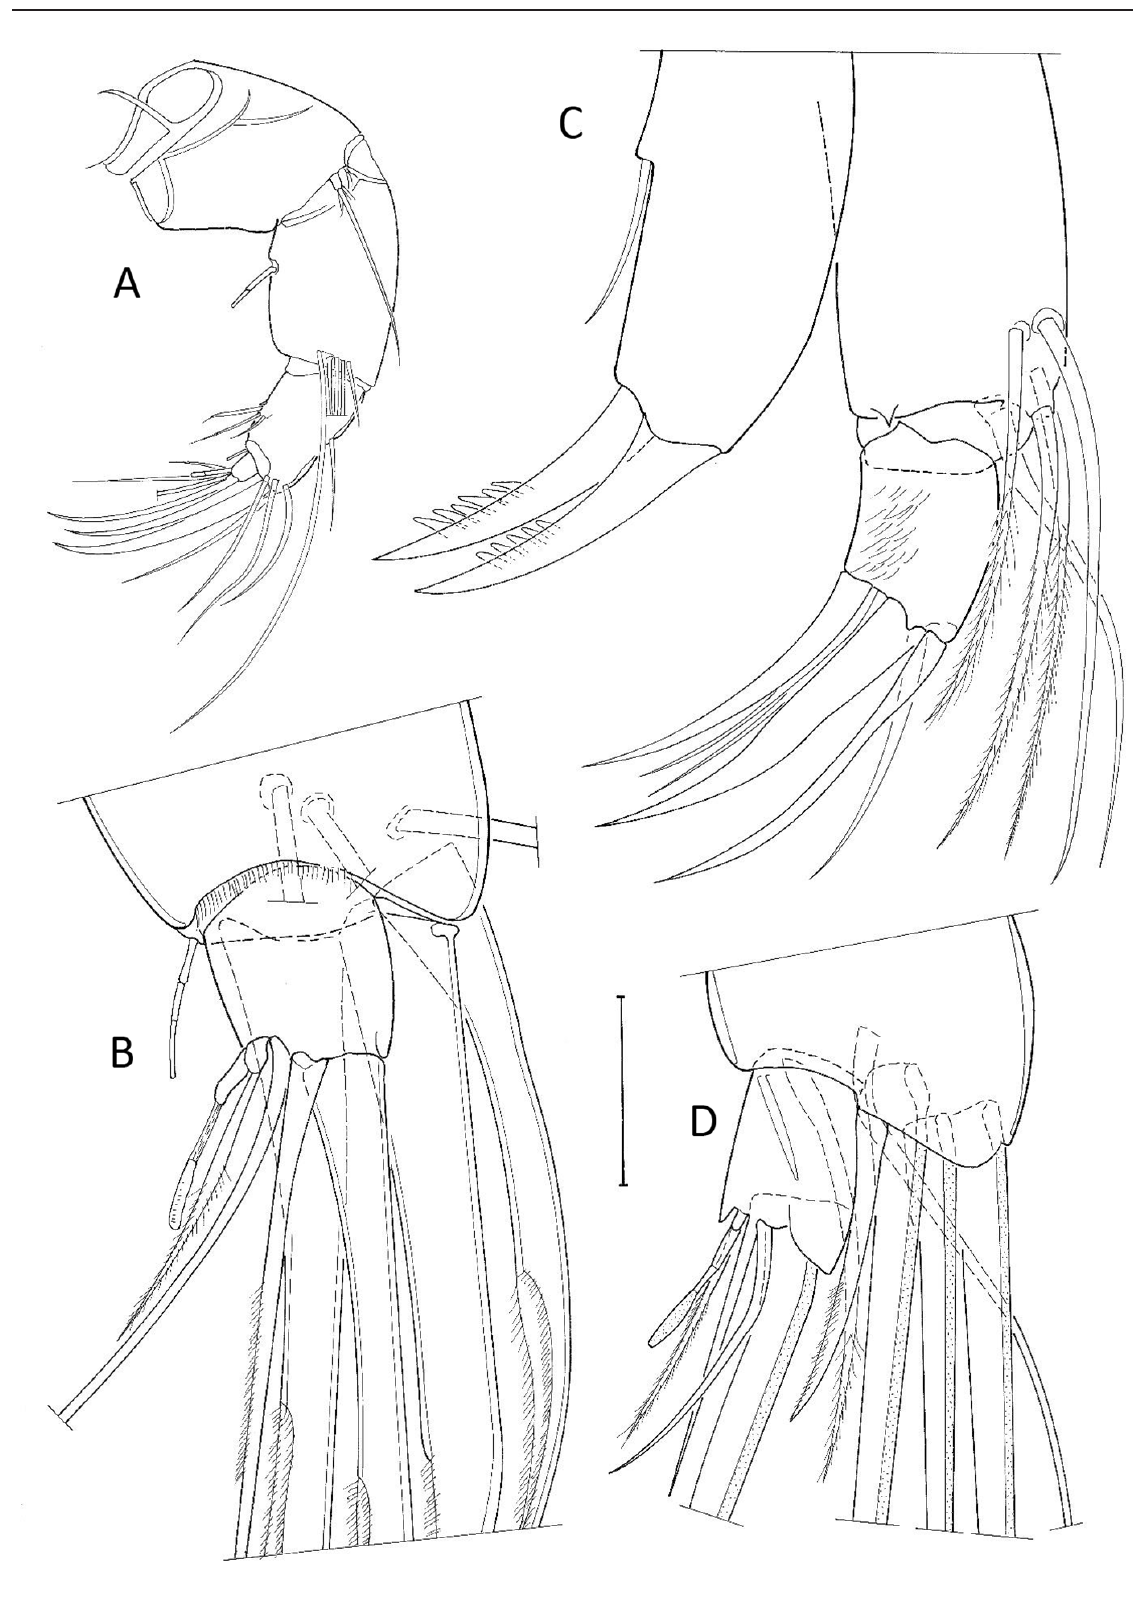
Fig. 4. Patcypris outback gen. et sp. nov., Lake Carey. A–C . ♀ (WAM 67198). A. A2. B. A2, distal chaetotaxy. C. Mx1, palp and 3 rd endite showing Zahnborsten . D . ♂ (WAM 67197), A2, distal chaetotaxy. Scale: A= 232 µm; B–D = 37